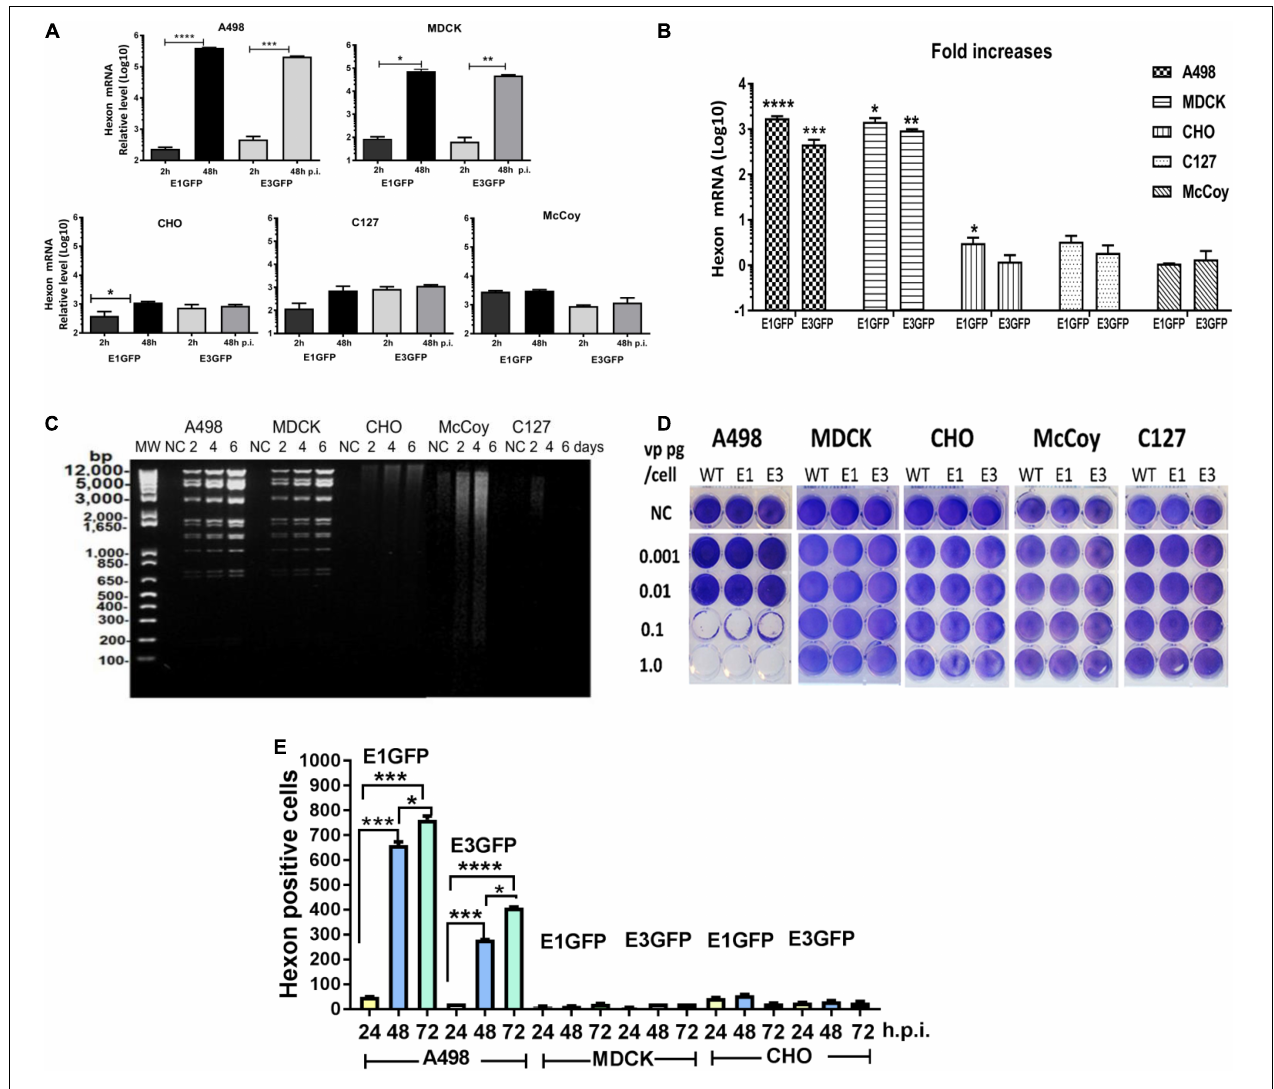
FIGURE 4 | Detection of virus replication in animal cell lines. (A) Quantification of Ad11p hexon gene expression in animal and human cells was measured to quantify progeny DNA at 48 h.p.i. (B) Fold increases in DNA copies. The asterisks indicate a significant difference, as determined by an unpaired t -test, * p < 0.05; ** p < 0.01; *** p < 0.001. The data are means ± SEs from three samples. (C) Detection of Ad-specific restriction enzyme fragments in the DNA from RCAd11pe1GFP-infected animal cells at different time points. Total viral DNA was extracted from one 175-cm 2 flask for each infected cell line at 48, 96, or 144 h. Purified viral DNA was digested with Bam HI; digested lambda DNA was used as a molecular weight (MW) marker; the corresponding lengths are indicated. (D) Toxicity assays were performed to determine the productive infection of the viruses. RCAd11pe1GFP resulted in different cytolytic effects in human and animal cells. (E)